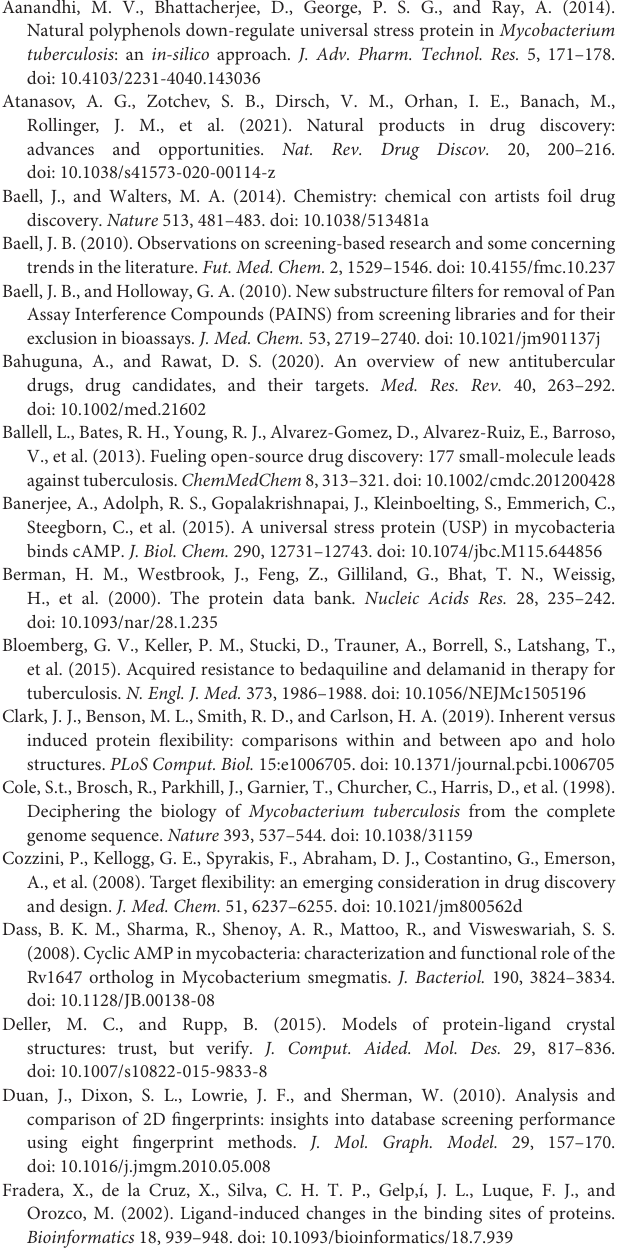
Supplementary Table 2 | Geometric criteria used for detecting non-covalent interactions between protein and the docked ligands. Supplementary Table 3 | Docking and Prime-MMGBSA results with molecular properties of top 100 compounds screened from the ChEMBL library. Supplementary Table 4 | Docking and Prime-MMGBSA results of compounds from secondary